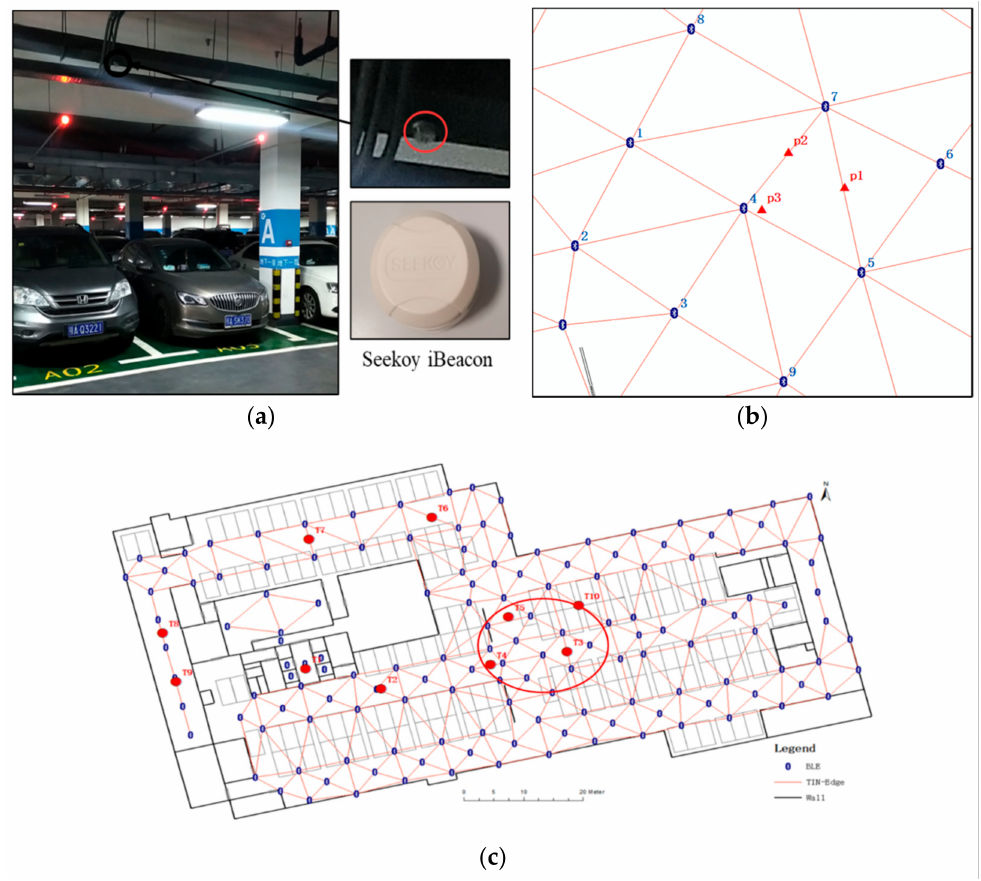
Figure 9. Experimental scene. ( a ) Parking lot environment and beacon deployment. ( b ) Test points for virtual area recognition. ( c ) Test points for accuracy